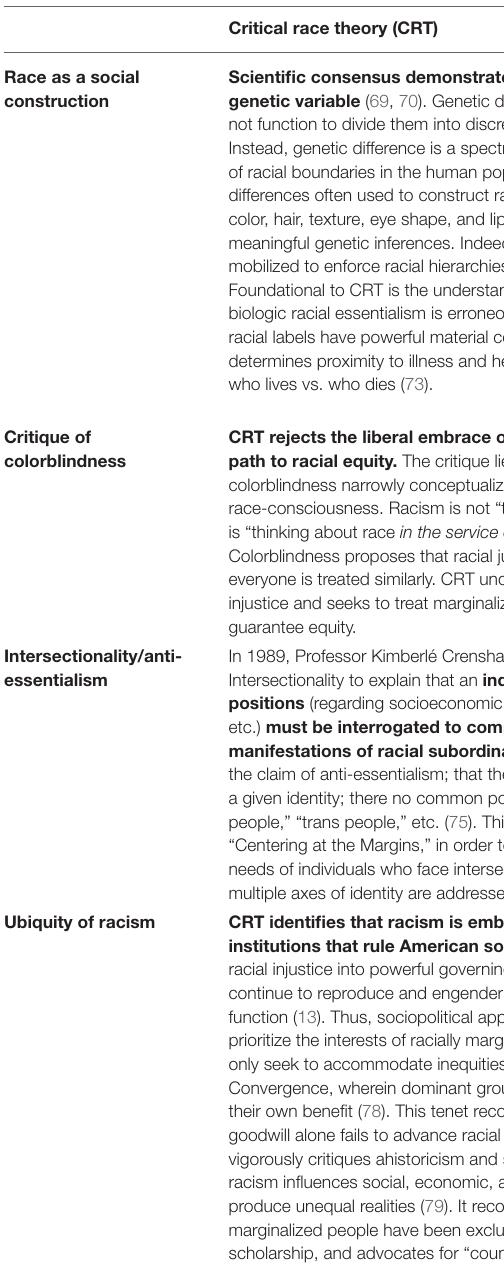
TABLE 2 | Critical race theory adapted to medical education (MedCRT)